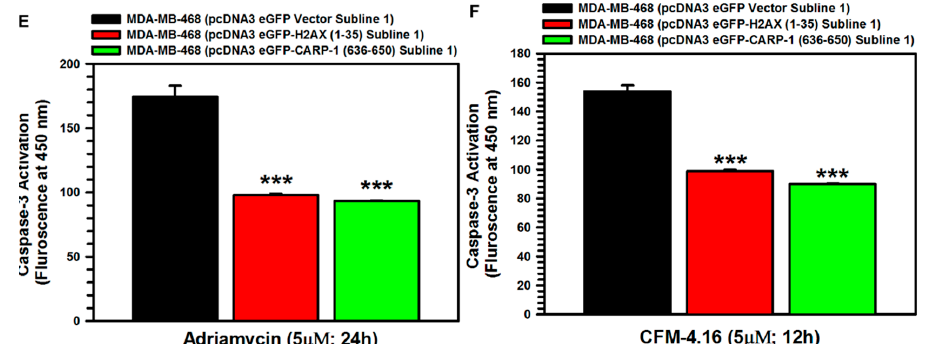
Figure 7. Disruption of H2AX interaction with CARP-1 results in enhanced viabilities of CFM-4-, CFM-4.16-, or Adriamycin-treated cells in part due to reduced apoptosis. ( A , C , D ) Indicated MDA- MB-468 cell lines were treated with DMSO (Control), or with the noted dose and time of Adriamycin, CFM-4, or CFM-4.16 compounds. Determination of viable/live cells was carried out by MTT assay as described in Section 2. ( B , E , F ) Cell lysates derived from vehicle DMSO (Control), or CFM-4-, CFM- 4.16-, or Adriamycin-treated cells were added to the wells that had immobilized fluorogenic substrates of noted caspases. The fluorescence released from the activated caspase-dependent cleavage of respective substrate was detected by a plate reader at the excitation and emission wavelengths of 380 nm and 460 nm, respectively, as detailed in Section 2. The columns in bar charts in panels A, C, D and B, D, F represent means of three and two independent experiments, respectively; bars, SE. For panels C and D, * p < 0.05, ** p < 0.01 and *** p ≤ 0.001 relative to the respective EGFP vector subline. For panels E and F, *** p ≤ 0.05 relative to the respective EGFP vector subline.